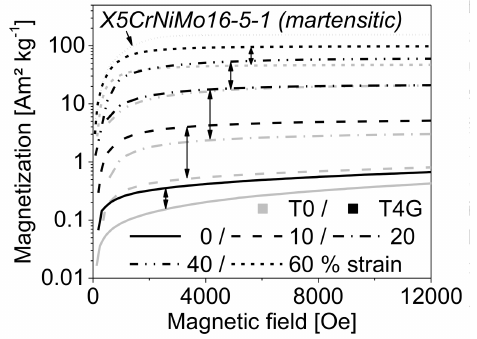
Figure 11. Magnetization curves of the syntactic foam with 40 vol % S60HS, the pure TRIP-steel bulk specimens and the fully martensitic reference material with regard to different deformation degrees under quasi-static loading.